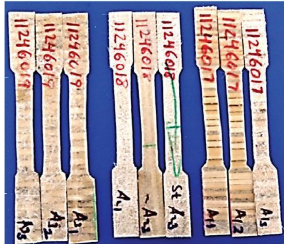
Figure 7: Test samples for tensile strength.